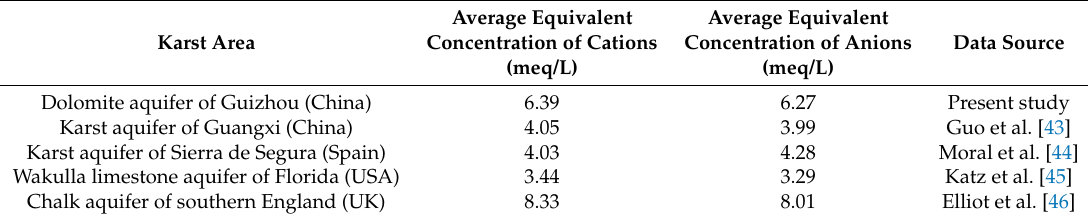
Table 3. Geochemical characteristics of karst groundwater in different karst